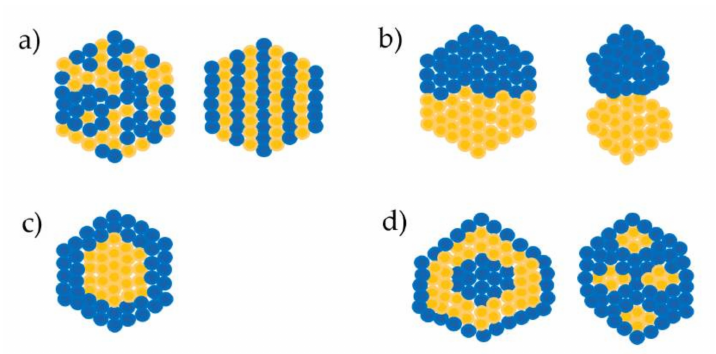
Figure 1. Types of bimetallic alloyed nanoparticles. ( a ) Mixed alloyed nanoparticles; ( b ) Sub-cluster segregated alloyed nanoparticles; ( c ) core-shell alloyed nanoparticles; ( d ) multiple core–shell alloyed nanoparticles